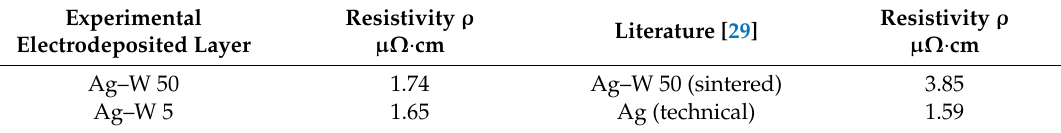
Table 3. Measurements of specific electrical resistivity using the four-point probes